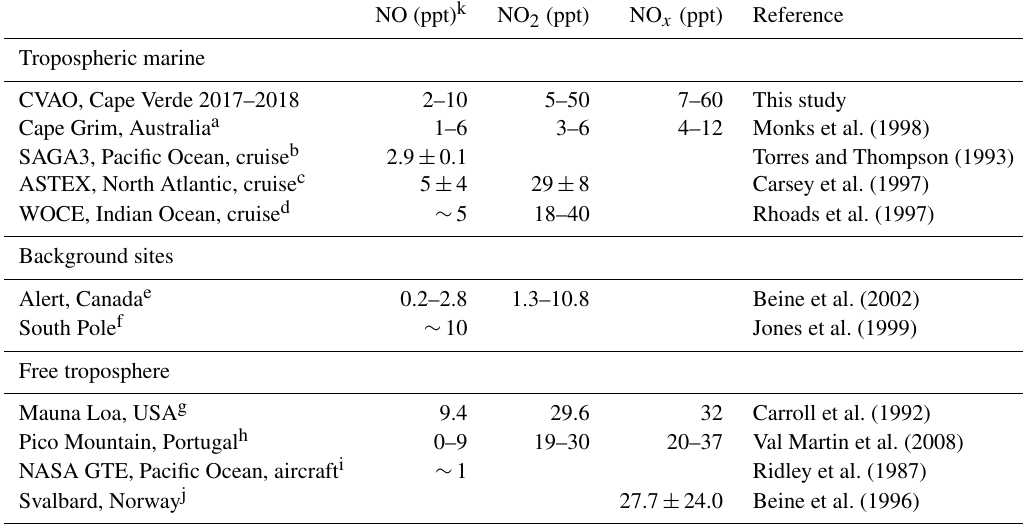
Table 3. NO, NO 2 , and NO x mixing ratios at different low NO x